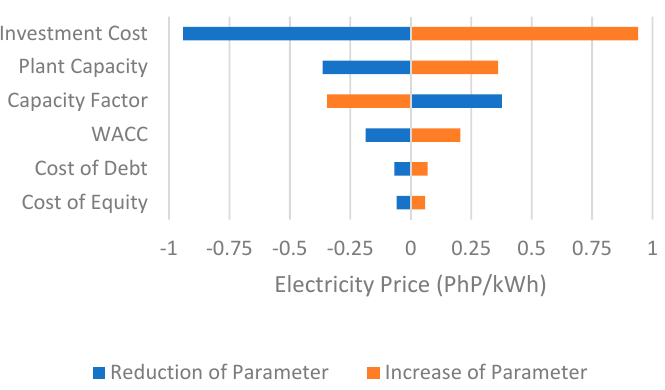
Figure 33. Sensitivity analysis of electricity price to different parameters (SWT-3.6-120).